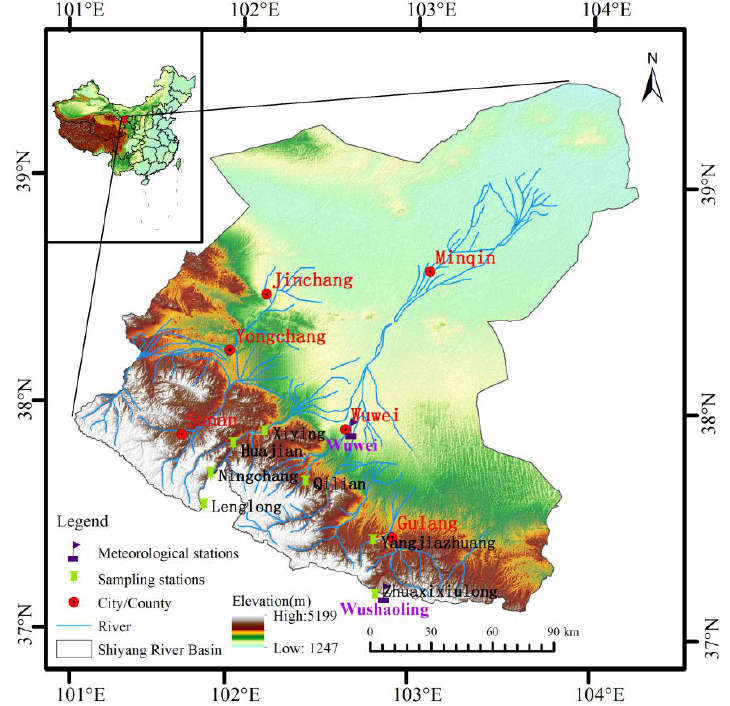
Figure 1. Geographical location and sampling point distribution of the study area.